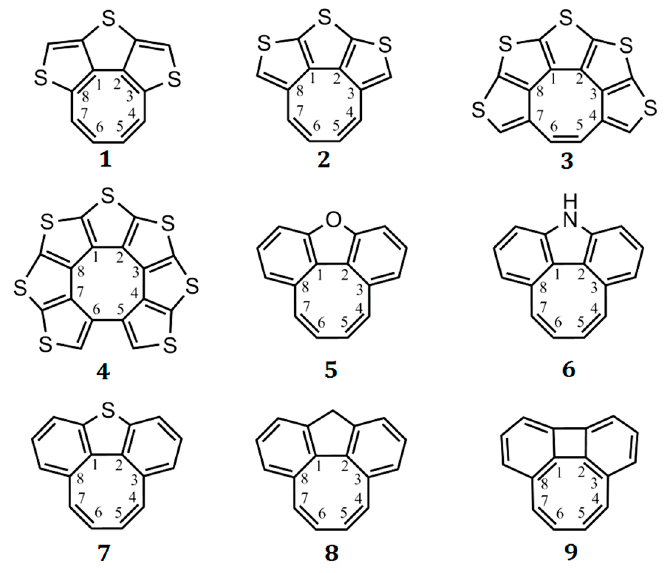
Figure 1. Structure of the quasicirculenes 1 – 9 .